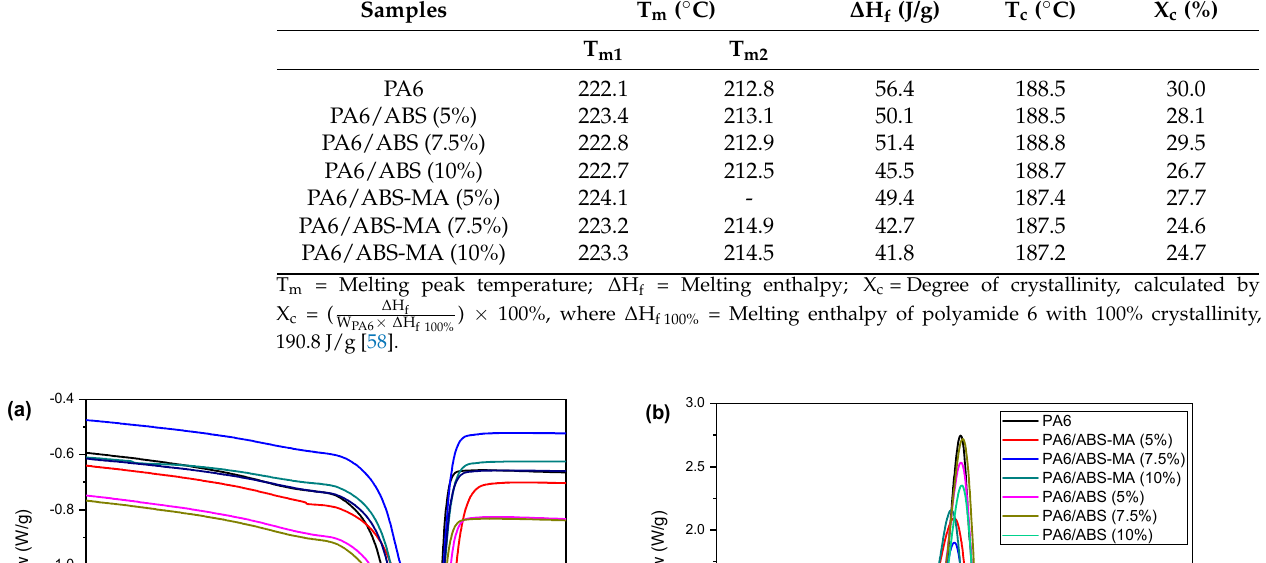
Table 4. Melting and crystallization parameters of PA6 and its blends: PA6/ABS and PA6/ABS-MA. Samples